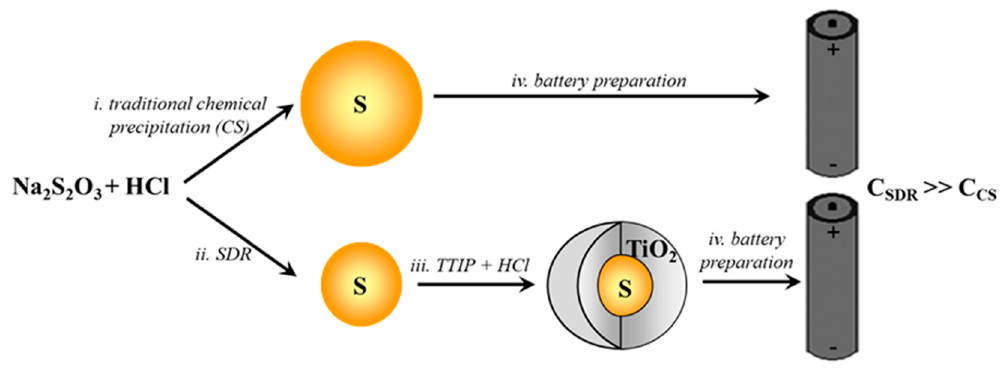
Figure 1. Overview of the process.Reactants and conditions: (i) Na 2 S 2 O 3 + HCl 1:2, 30 min, room temperature; centrifugation. (ii) Na 2 S 2 O 3 + HCl 1:2 at 1200 rpm disk rate; centrifugation. (iii) S by